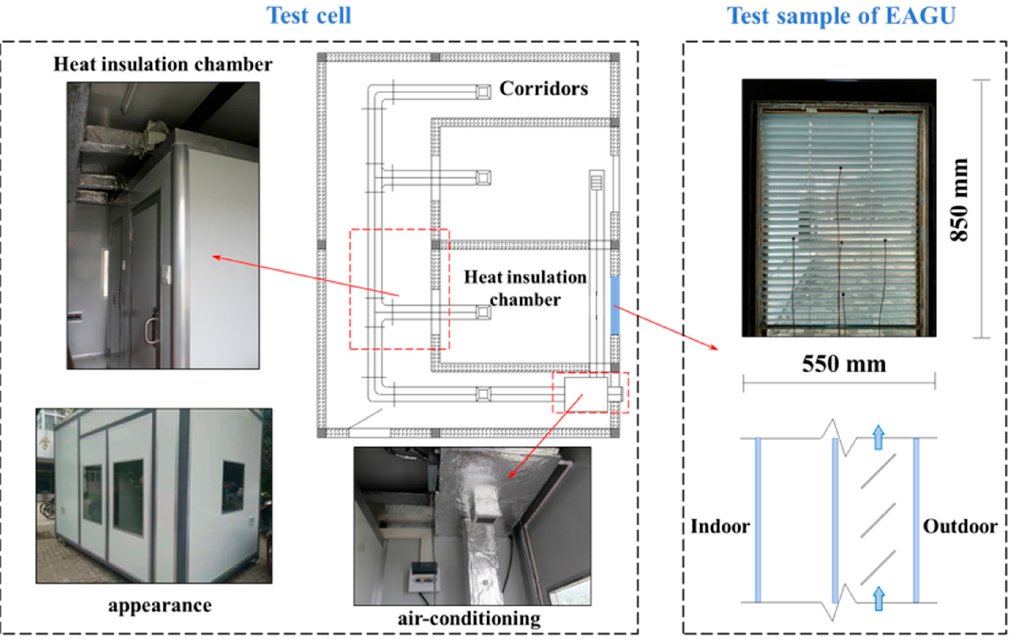
Figure 3. Overview of the experimental platform of the EAGU [35]. Reprinted with permission from ref. [35]. Copyright 2018 Elsevier.